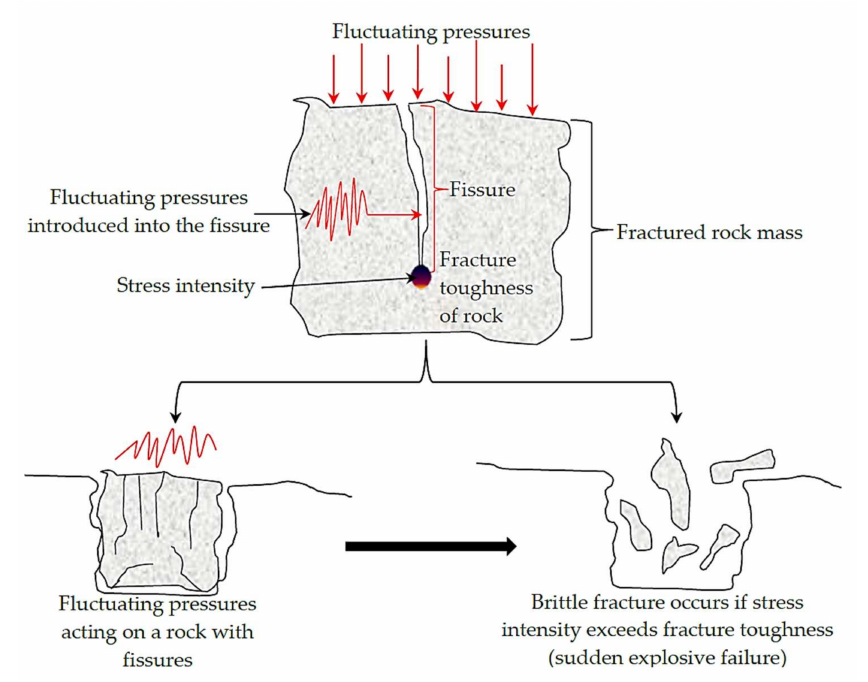
Figure 2. Erosion by brittle fracture or instant hydrofracturing [7]. The final mechanism of erosion is continuous fragile fracturing or fatigue erosion. This mechanism occurs when the instantaneous brittle fracture of rock mass is not possible, as the intensity of the stress in the joints does not exceed the resistance of the rock mass. The rock mass is eroded, however, by fatigue pressure loads that exist in the joints. This type of erosion is highly dependent on time (Figure